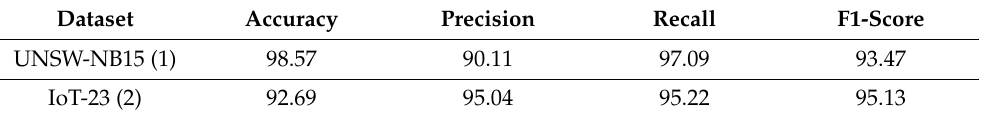
Table 8. The inference results (in %) for the two trained models on the MAX78000EVKIT. Dataset Accuracy Precision Recall